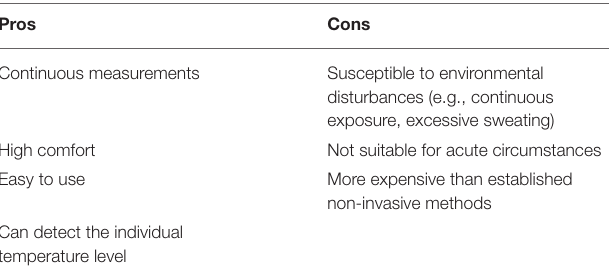
TABLE 2 | Summary of advantages and disadvantages of the adhesive axillary thermometer.